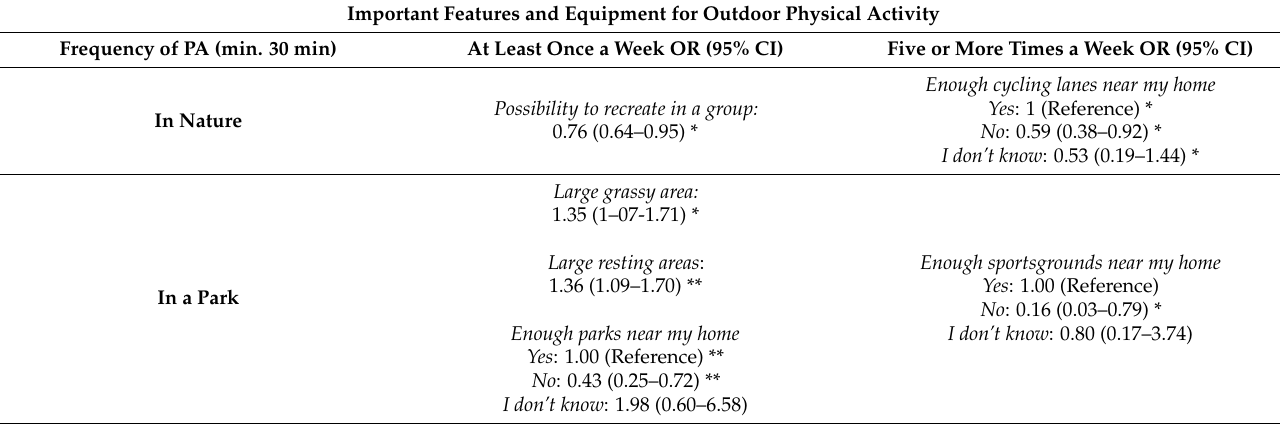
Table 4. The Association between Green Space Characteristics and Physical Activity